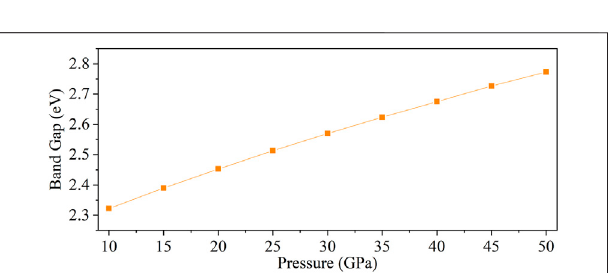
FIGURE 5 | Band gap of CaO 3 under 10 – 50